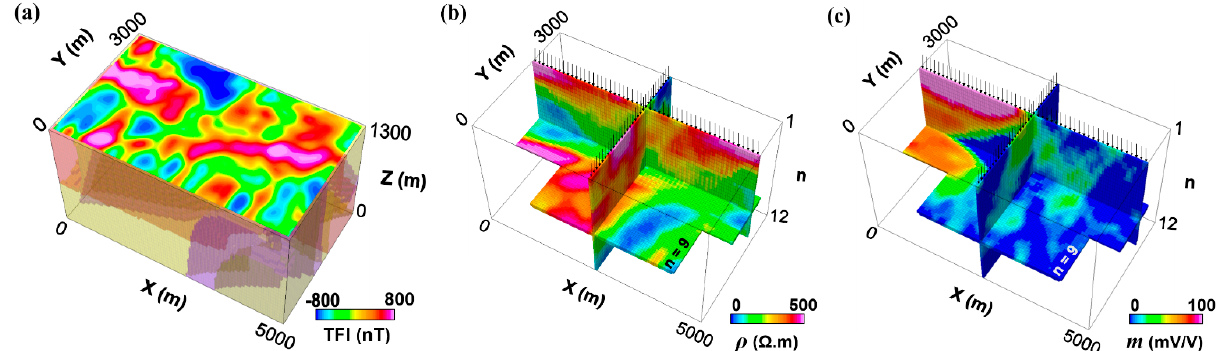
Figure 8. The geophysical responses ( S d ) of the mixed physical properties ( P j ): ( a ) total magnetic field intensities after reduction to magnetic pole; ( b ) apparent resistivities; ( c ) apparent chargeabilities. DC/IP responses are presented on two NS and EW pseudo-sections as well as a horizontal slice corresponding to the dipolar separation of n = 9. The arrows (black) indicate the location of simulated DC/IP electrodes.